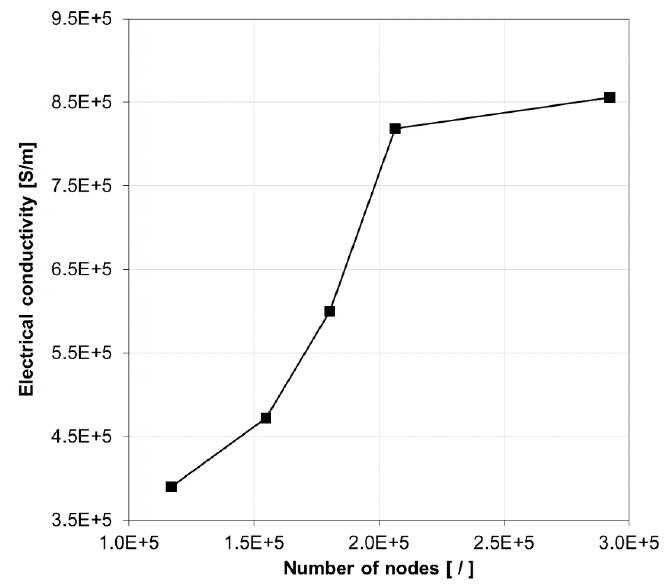
Figure 9. Electrical conductivity for different model mesh refinements for 21 vol% filler loading. Nanomaterials 2020 , 10 , x FOR PEER REVIEW